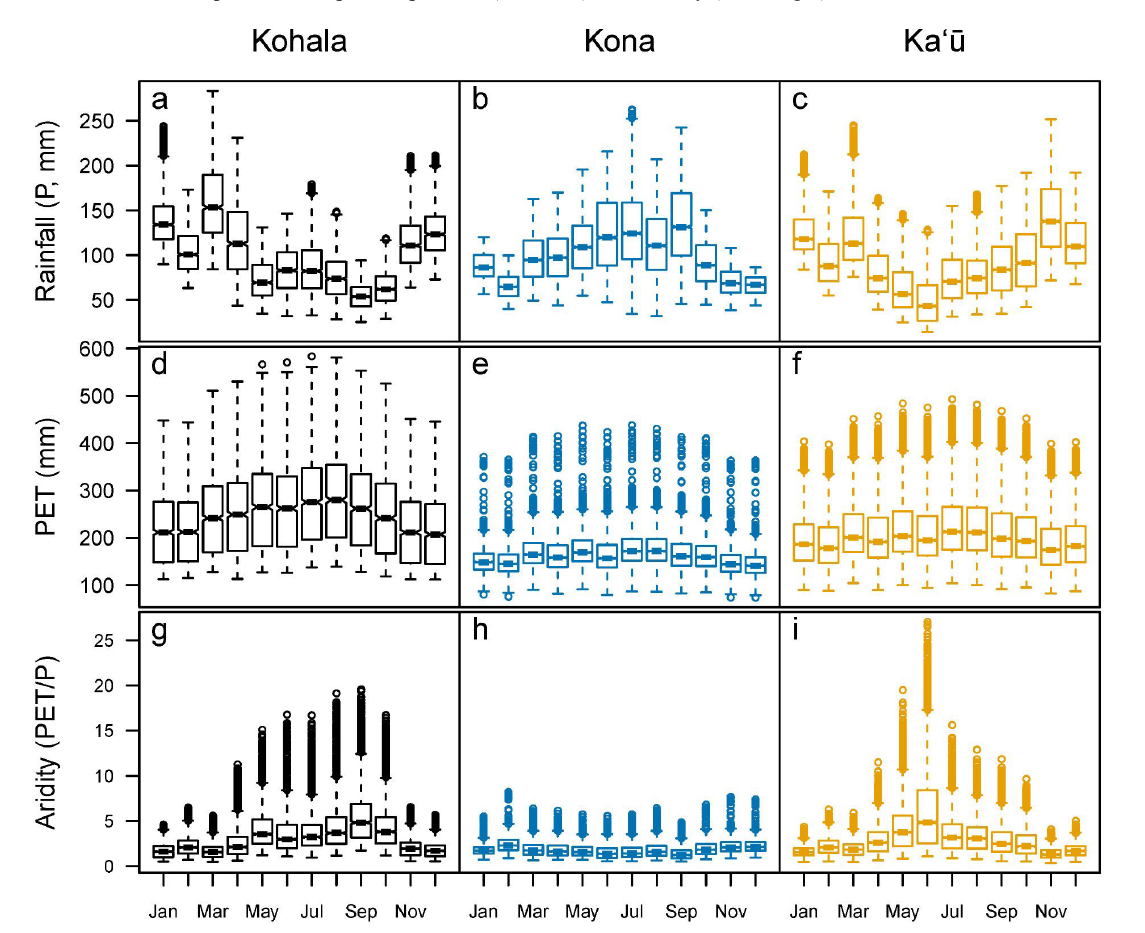
Fig. 4 . Intra-annual (seasonal) variation within the Kohala, Kona, and Ka ʻū field systems for rainfall (a–c),